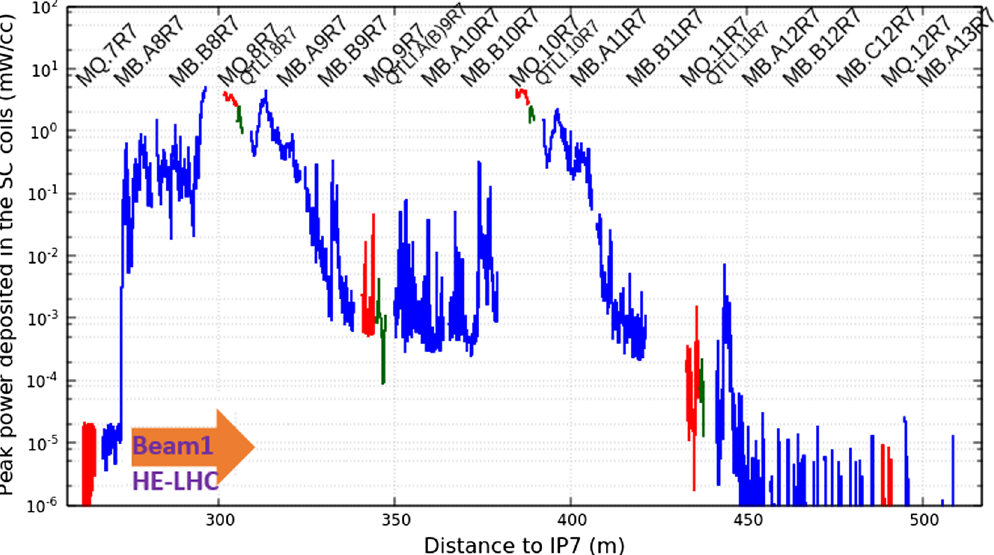
FIG. 12. Profile of peak power density in the SC coils along the IR7 cold magnets of HE-LHC, in the presence of TCLD collimators (one at the end of cell 8, before MQ8, and the other at the end of cell 10 just before MQ10). The color code is as in Fig. 11. Values are calculated for 0.2 h BLT and are radially averaged over the SC cable